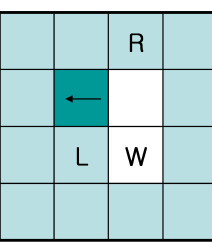
Figure 15. Problem with TPA. TPA must start with white left (L), left-rear (W) and right-rear (R) pixels. However, generic inner contours cannot satisfy these